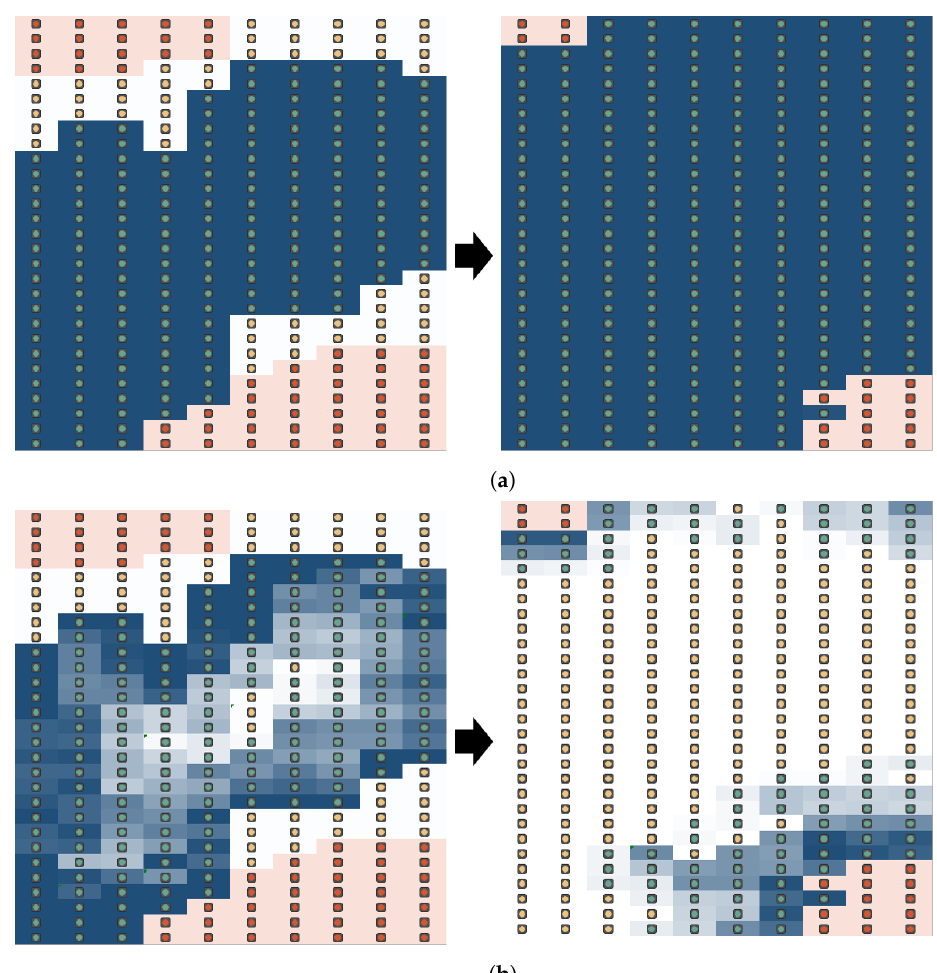
Figure 4. Illustration of our approach. ( a ) Illustration of conventional white-hat botnet diffusion. ( b ) Illustration of diffusion using our